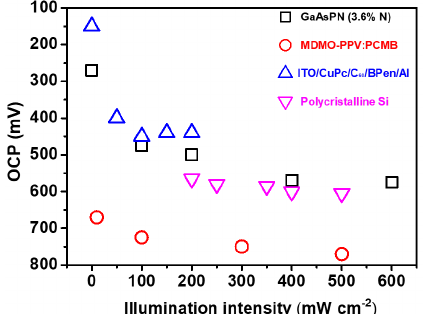
Figure 7. Open-circuit potential (OCP) of different type of solar cells vs illumination intensity: photoelectrode of GaAsPN (3.6%N) 3M H 2 SO 4 (V vs. Ag/AgCl) [47], MDMO-PPV: PCMB solar cell device [48], DSSC solar cell (ITO/CuPc/C 60 /BPen/Al) [49], polycrystalline Si [50].